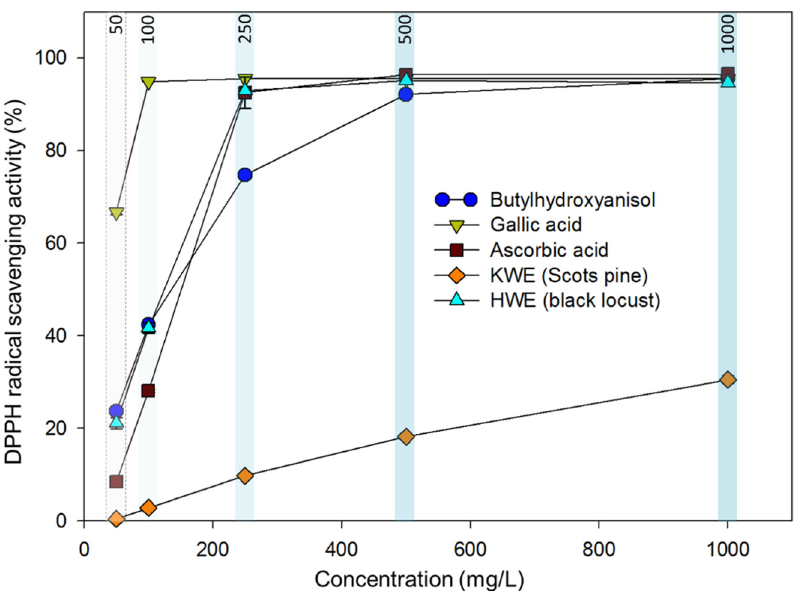
Figure 9. DPPH radical scavenging activity (RSA, %) for the KWE of P. sylvestris and HWE of R. pseudoacacia and references (BHA, GA and AA). BHA, butylhydroxyanisole; GA, gallic acid; AA, ascorbic acid; KWE, treating solution of Scots pine knotwood extract (1%, w/v) and HWE, treating solution of black locust heartwood extract (1%, w/v).